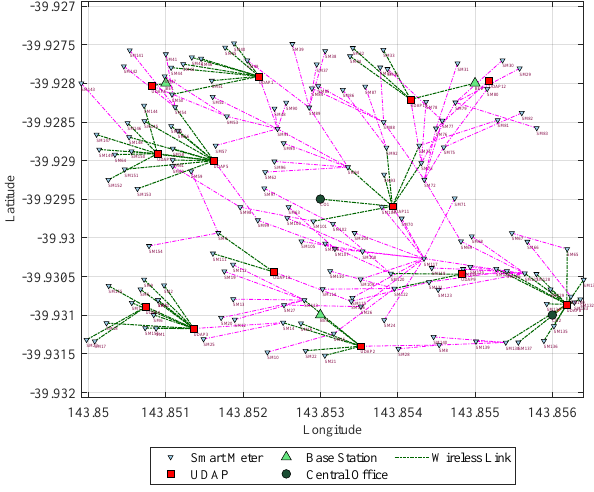
Figure 6. Final network topology of Scenario 4 with capacity of 20 users. Employing the wireless network simulator QualNet Developer 5.2, the topology of the Zigbee network of Figure 7 obtained from the Matlab optimization algorithm